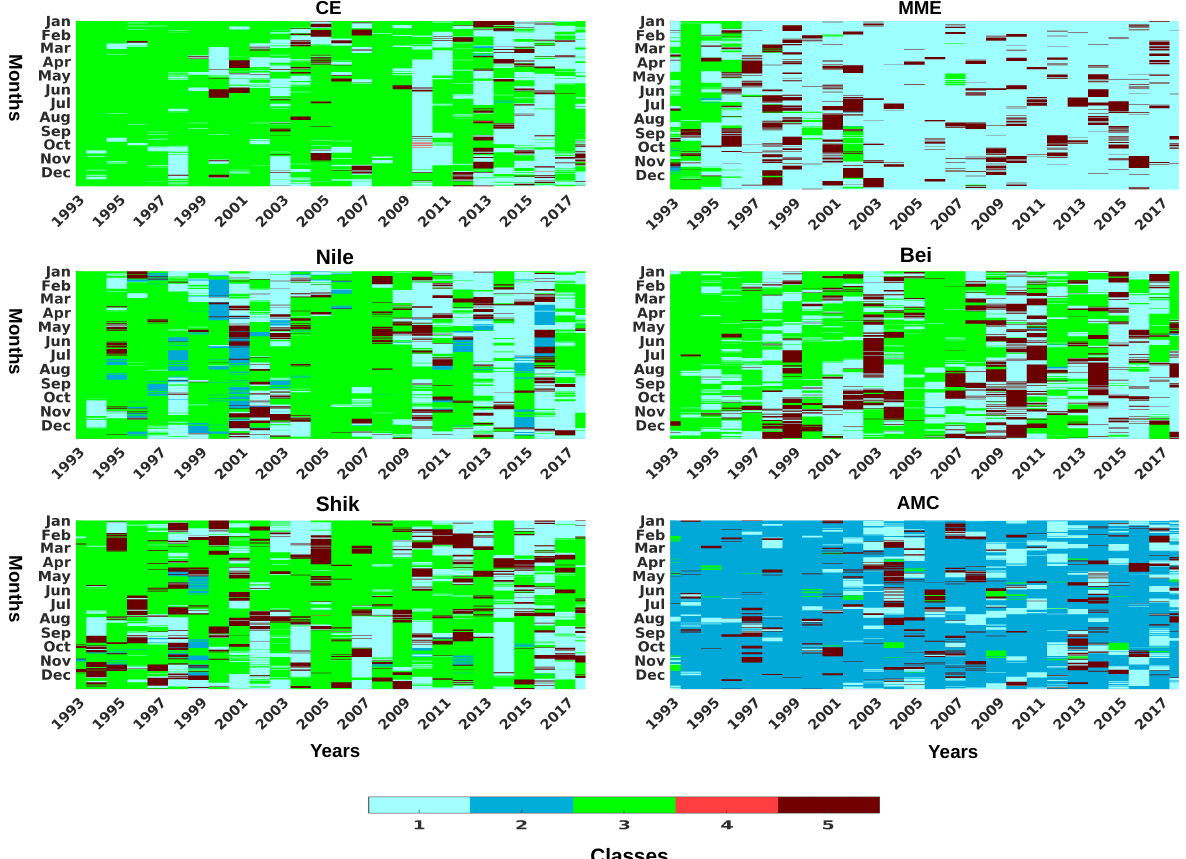
Figure 5. The daily dominant cluster in each box from 1993 and